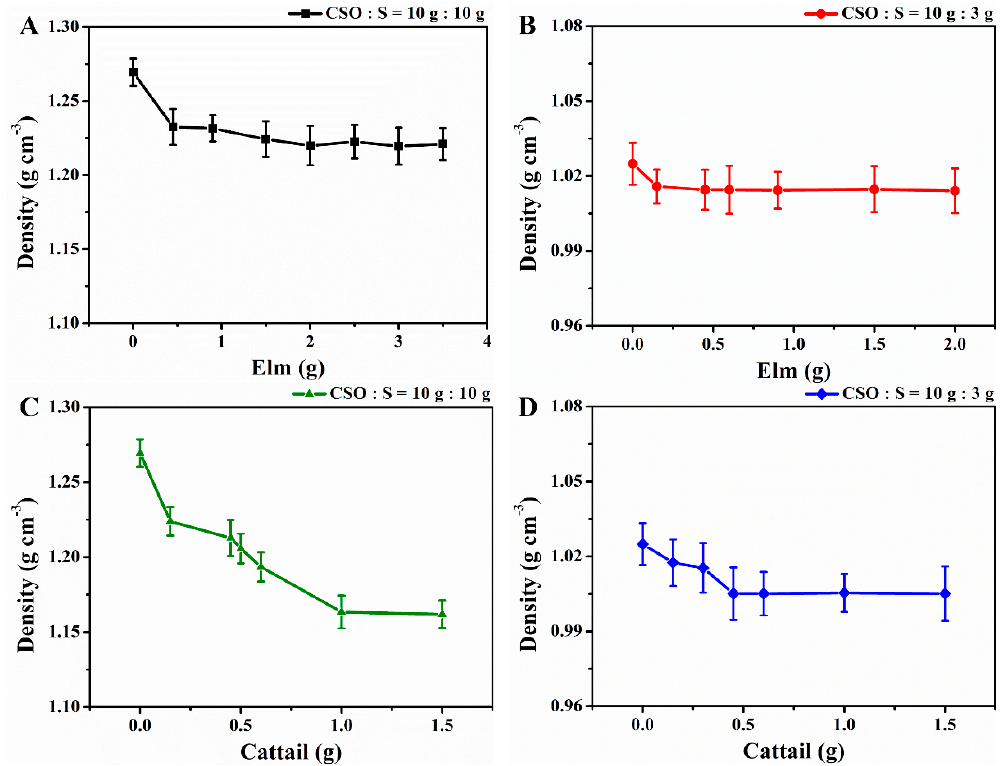
Figure 2. Effect of filler content on density of bio-based polysulfide composites. ( A ) 10.0 g CSO + 10.0 g S + elm, ( B ) 10.0 g CSO + 3.0 g S + elm, ( C ) 10.0 g CSO + 10.0 g S + cattail, ( D ) 10.0 g CSO + 3.0 g S + cattail.